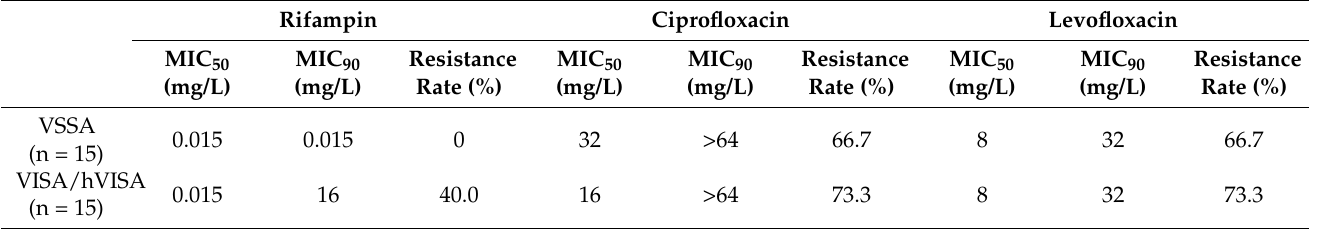
Table 1. MIC distribution of antimicrobials against methicillin-resistant Staphylococcus aureus strains. Rifampin Ciprofloxacin